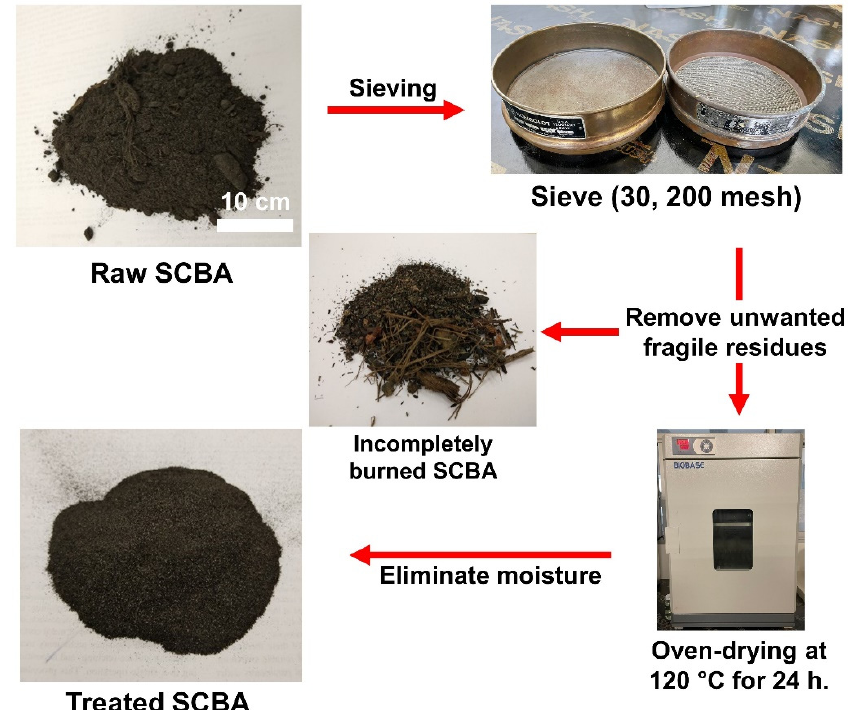
Figure 1. A process for treatment of the raw sugarcane bagasse ash (SCBA).